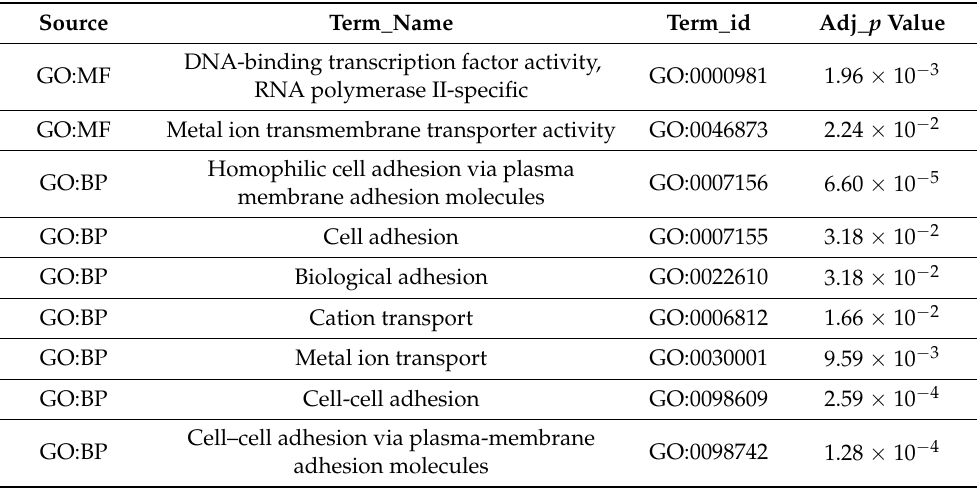
Table 1. Gene ontology enrichment analysis of DM CpGs categorized in molecular functions (MF) and biological processes